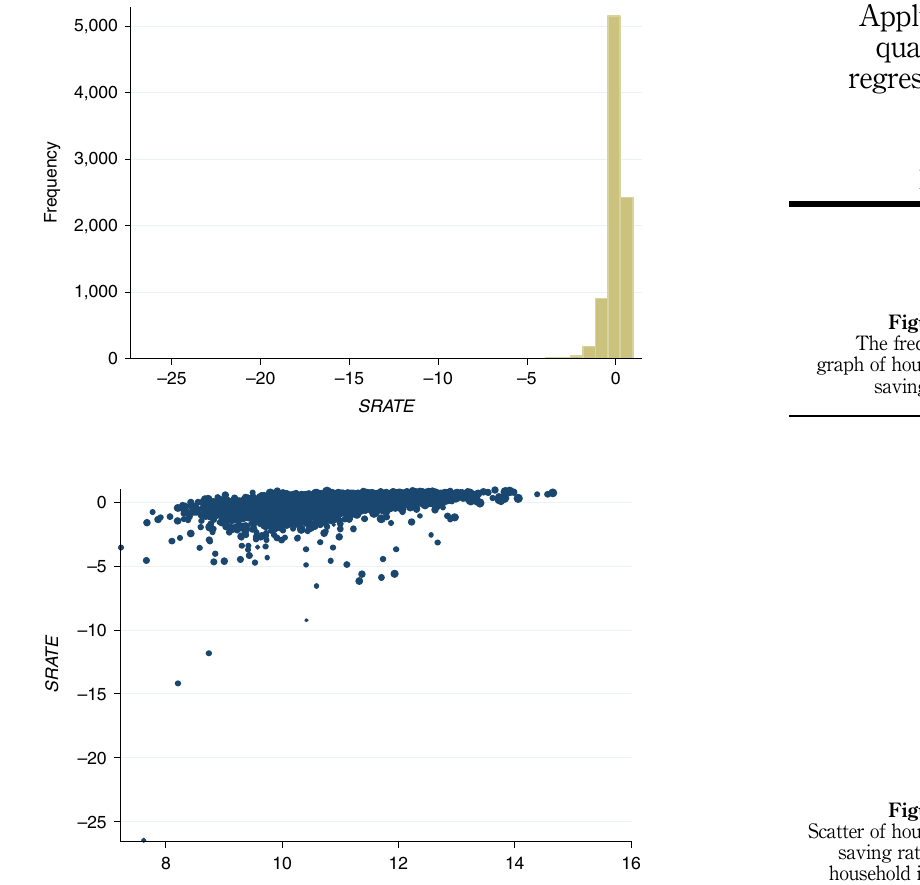
Figure 1. The frequency graph of household saving rates